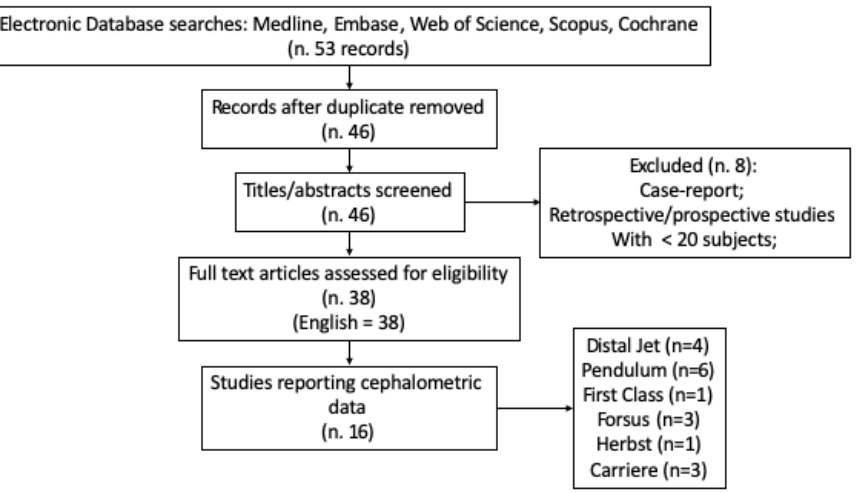
Figure 1. Flow chart of the research